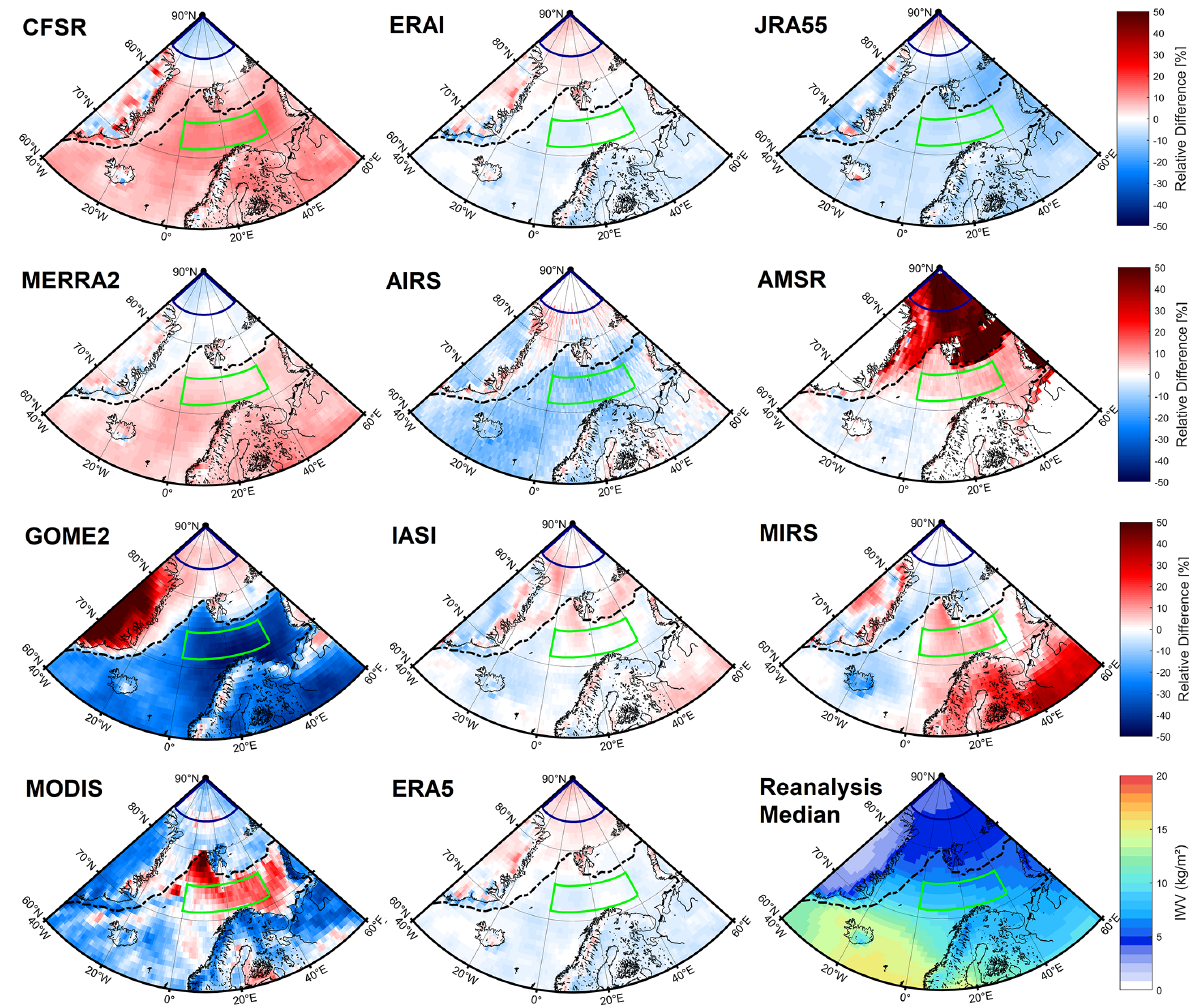
Figure A2. Relative difference between the reanalysis median (bottom right; CFSR, ERA-Interim, JRA-55, MERRA2) and the individual products over the study area for May 2017. The monthly mean sea ice edge for 15% sea ice concentration derived by the AMSR is shown as a black dash-dotted